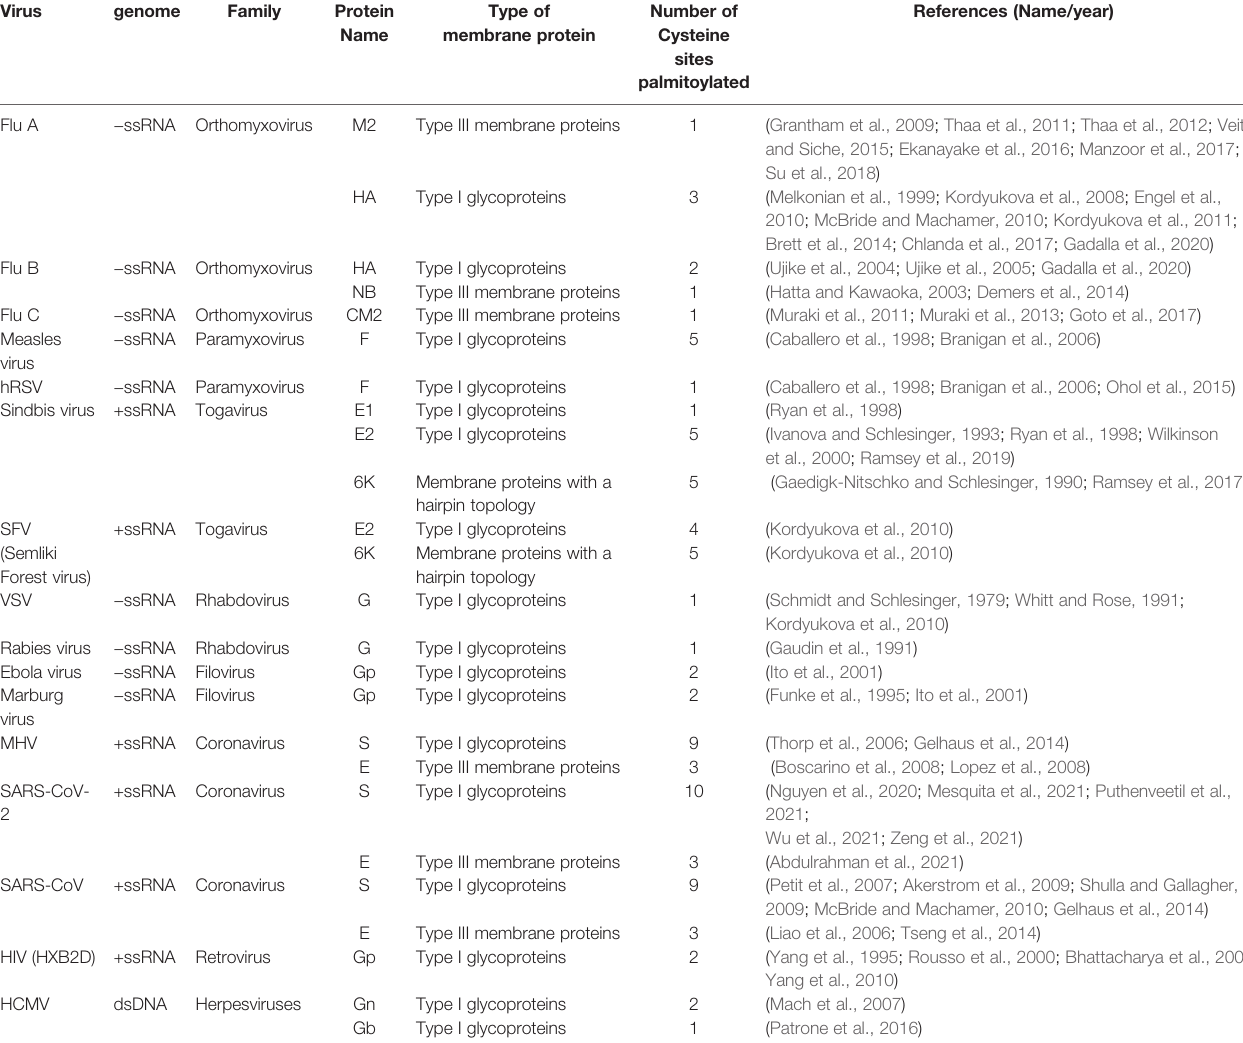
TABLE 1 | Summary of some palmitoylated viral proteins